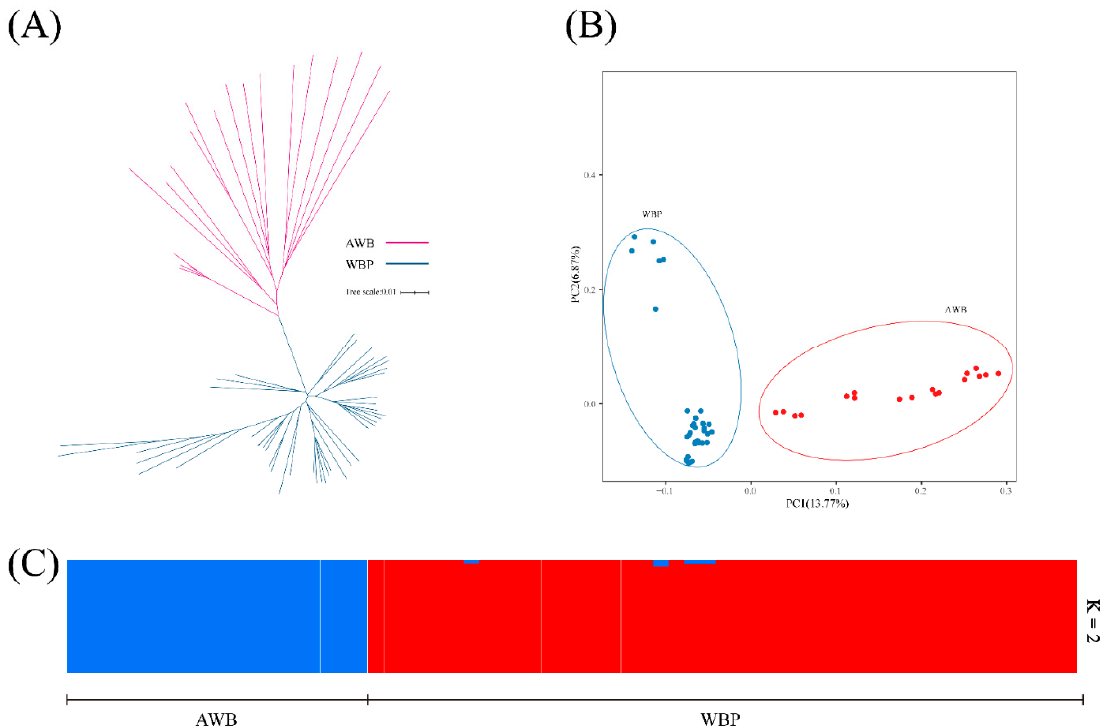
Figure 2. ( A ) Neighbor-joining tree constructed from CNV data in study population. ( B ) PCA plots for the first two PCs for all 64 individuals, PC1 and PC2 explain 13.77% and 6.87% of the total variations, respectively. ( C ) Structure analysis on all the AWB and WBP with K = 2.